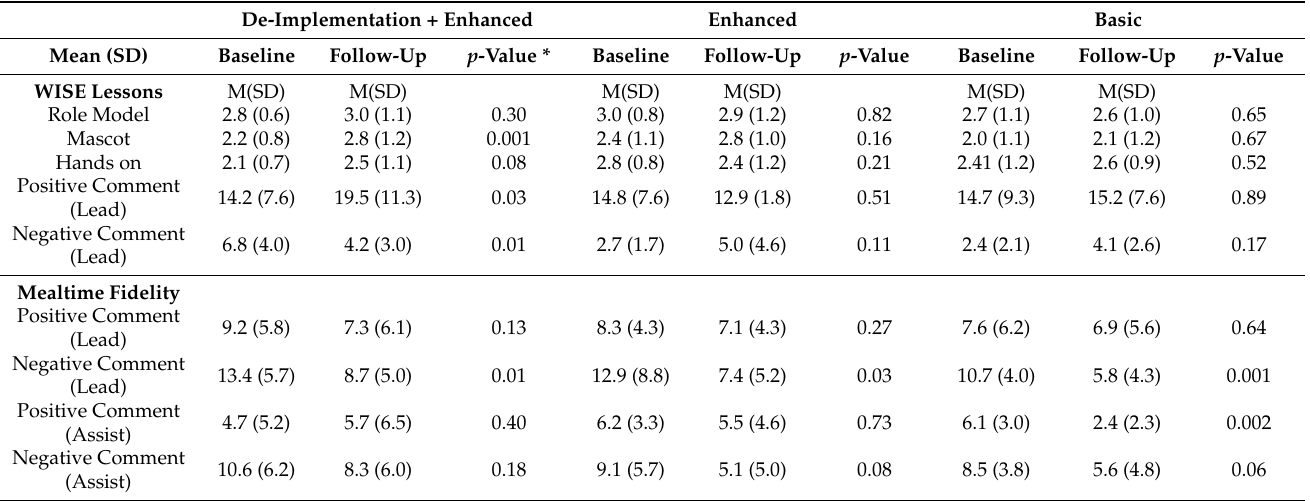
Table 3. WISE lesson and mealtime fidelity: between-group differences at baseline and within-group differences across time.